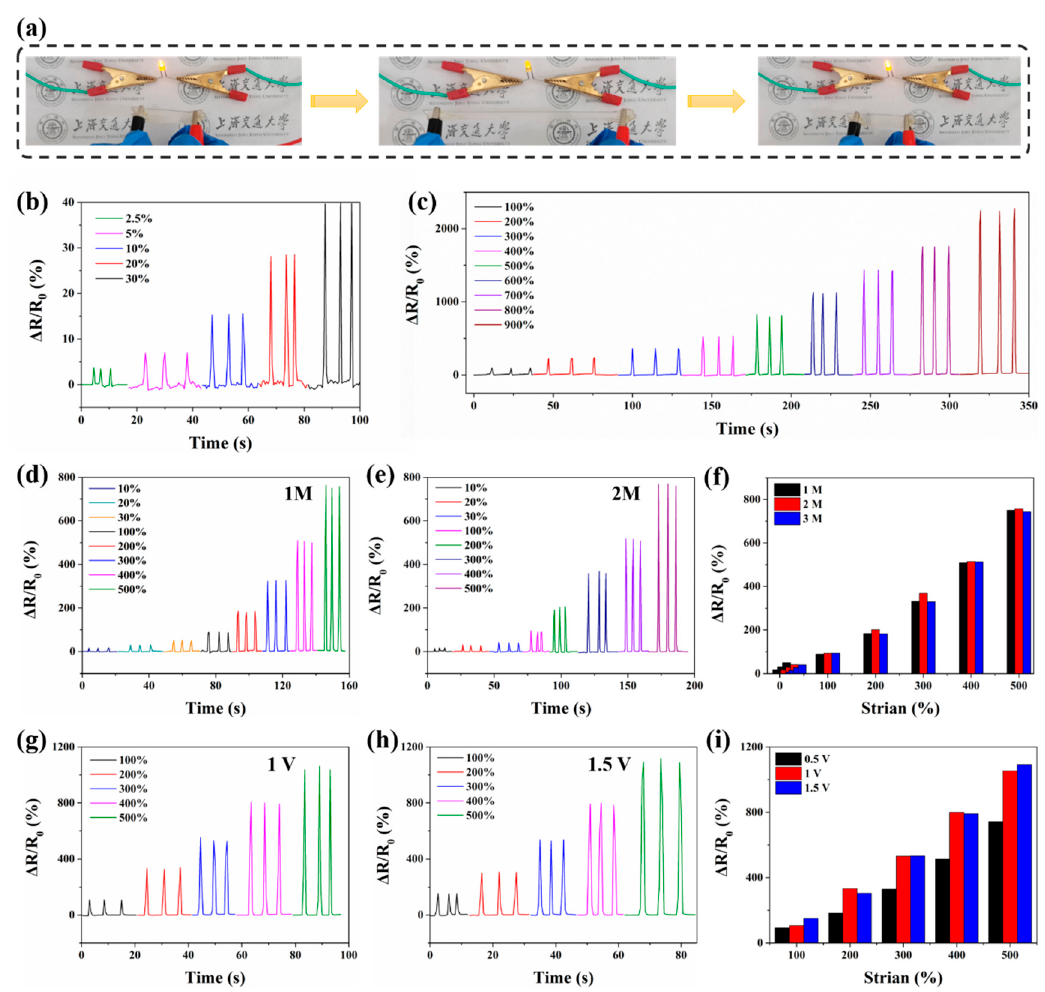
Figure 6. Mechanosensitive performances of the hydrogel. ( a ) The brightness of LED lamp observed at different hydrogel strains; ( b ) the RRCs of hydrogel strip at the elongation form 2.5% to 30%; ( c ) the RRCs of hydrogel strip at the elongation form 100 to 900%; ( d ) mechanical response performance of hydrogel with 1M Ca 2+ concentration under 10% to 500% strain; ( e ) mechanical response performance of hydrogel with 2M Ca 2+ concentration under 10% to 500% strain; ( f ) comparison of RRCs values of hydrogels with different Ca 2+ concentrations; ( g ) under 1 V, mechanical sensing under 10% to 500% strain; ( h ) under 1.5 V, mechanical sensing under 10% to 500% strain; ( i ) comparison of RRC values of hydrogels under diverse voltage.